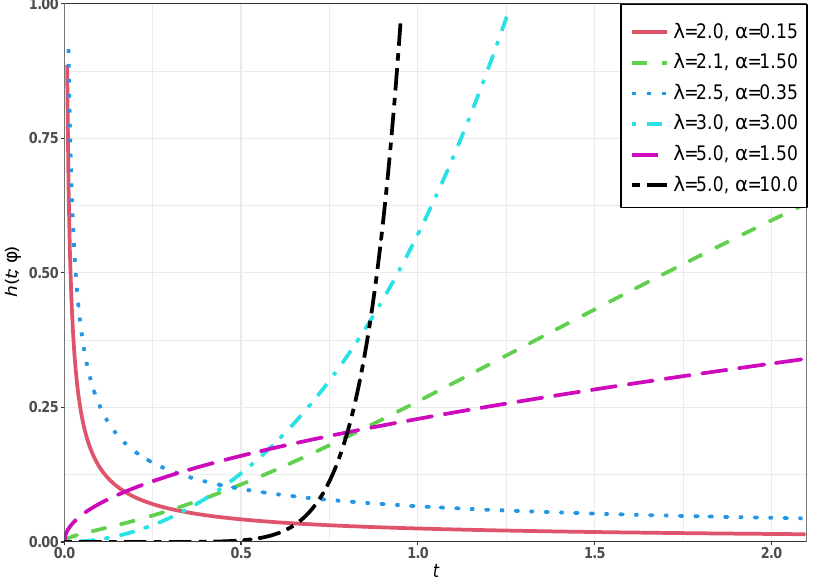
Figure 1. Hazard rat function shapes for the generalized Ramos–Louzada distribution considering different values of λ and α